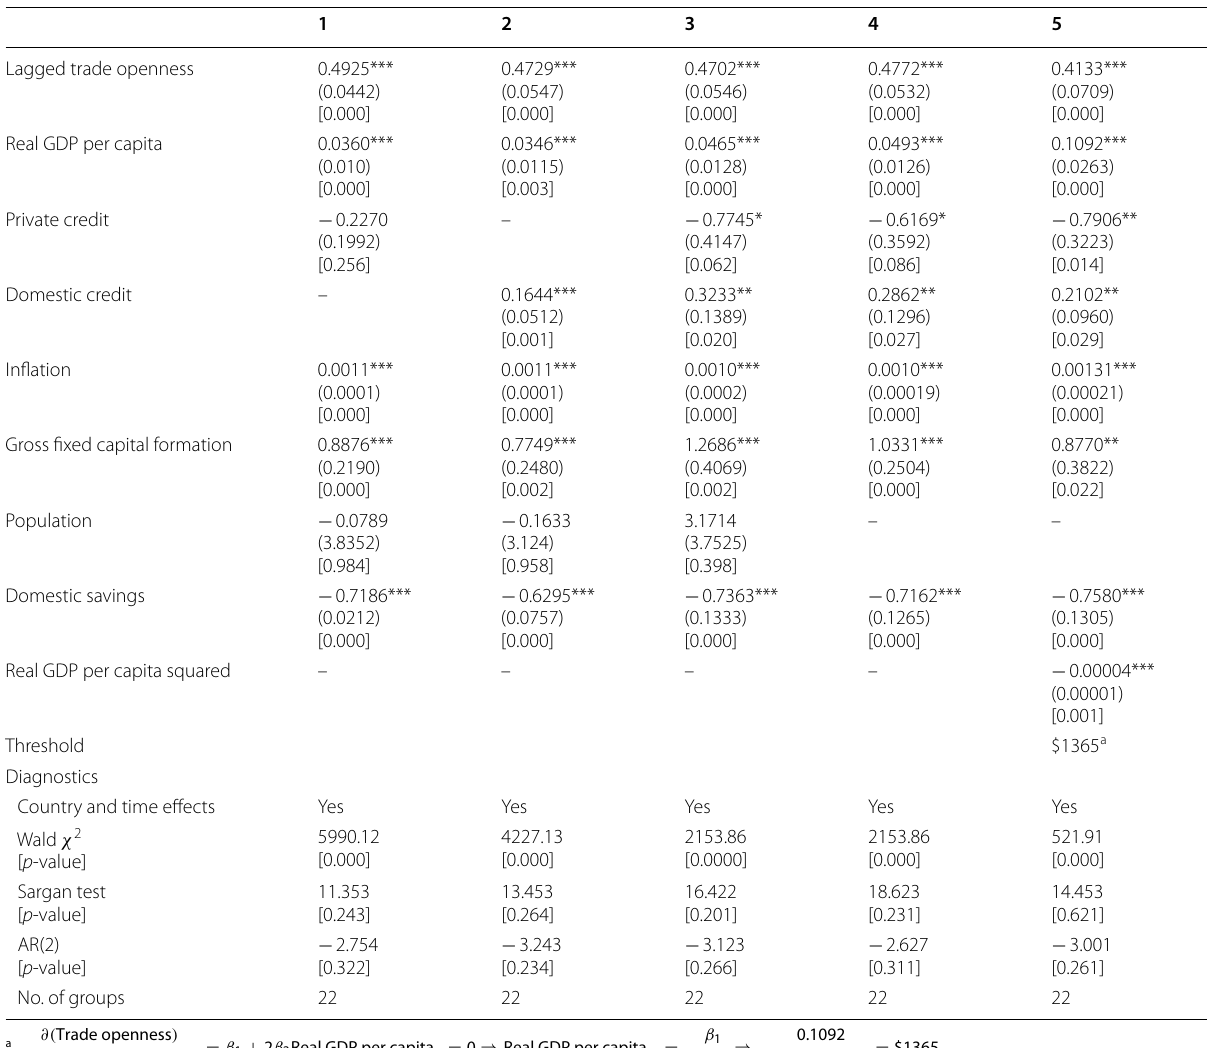
Table 2 Determinants of trade openness in